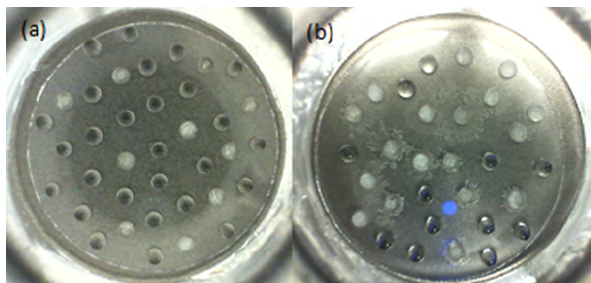
Figure 4. Examples of experiments conducted (a) with and (b) without a flow of dry nitrogen gas. (a) shows a single frame from an experiment where 10 droplets containing silver iodide were spread among droplets of pure water. A dry flow was employed to ensure ice growth did not take place. (b) shows a similar experiment where the dry flow was not employed and the resultant growth of ice across the slide which triggered freezing in pure water droplets. Both frames were taken at − 12 ◦